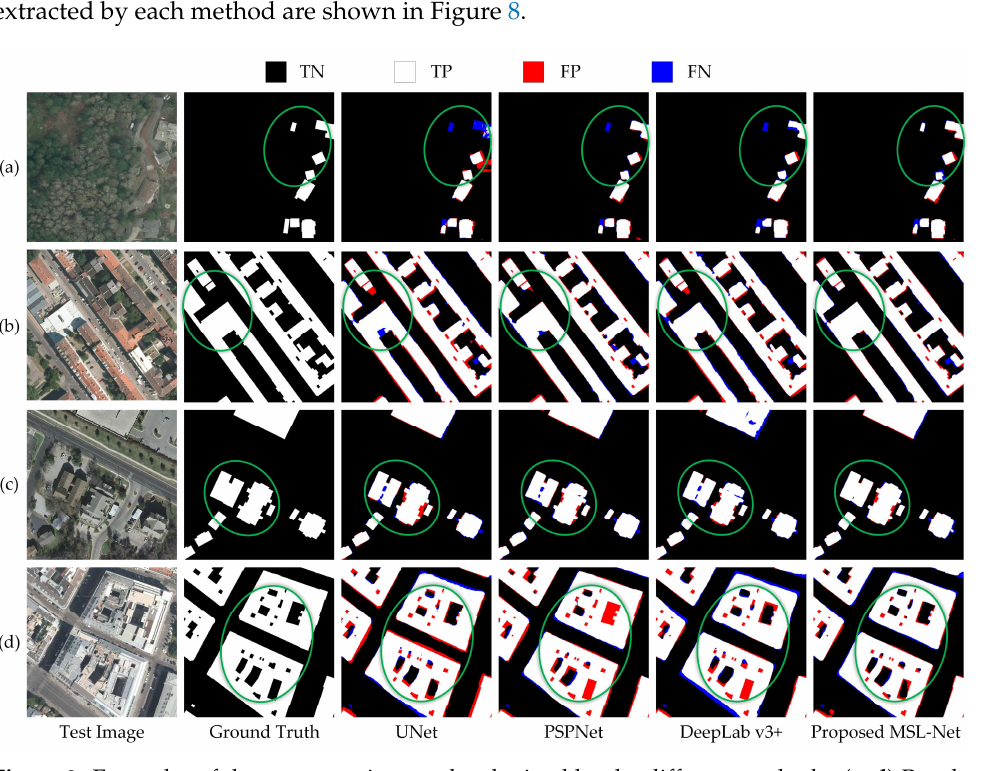
Figure 8. Examples of the segmentation results obtained by the different methods. ( a – d ) Results selected from the Inria dataset.